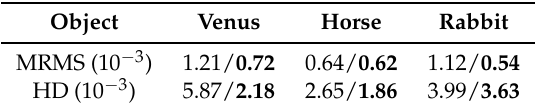
Table 14. Imperceptibility comparison with Wang et al.’s [3] method measured in terms of MRMS and MSDM for Horse and Venus models.